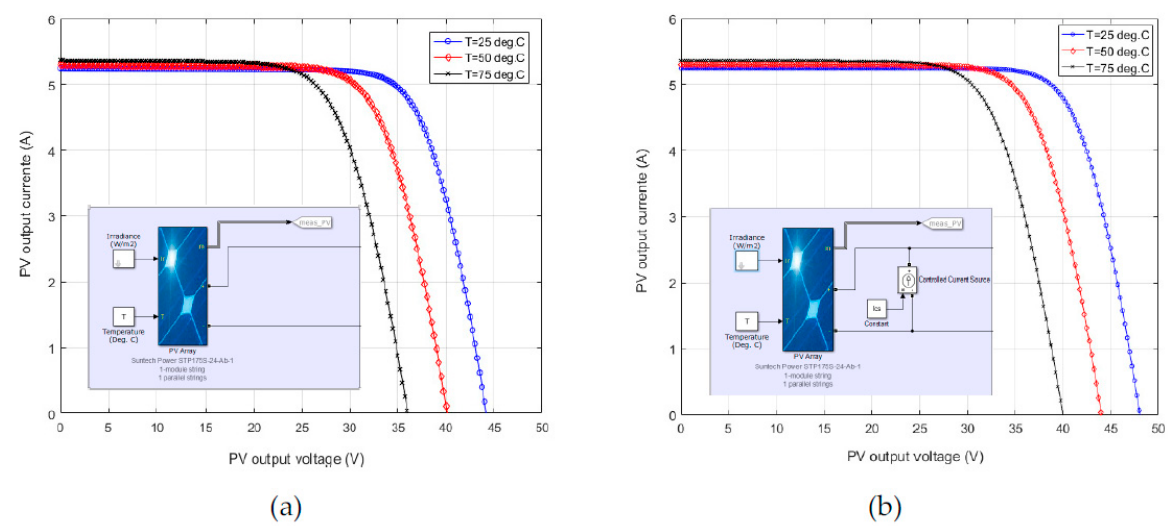
Figure 19. ( a ) actual I-V curve temperature variation of PV panel (STP175S-24) at STC. ( b ) emulated I-V curve temperature variation of the emulated PV source.